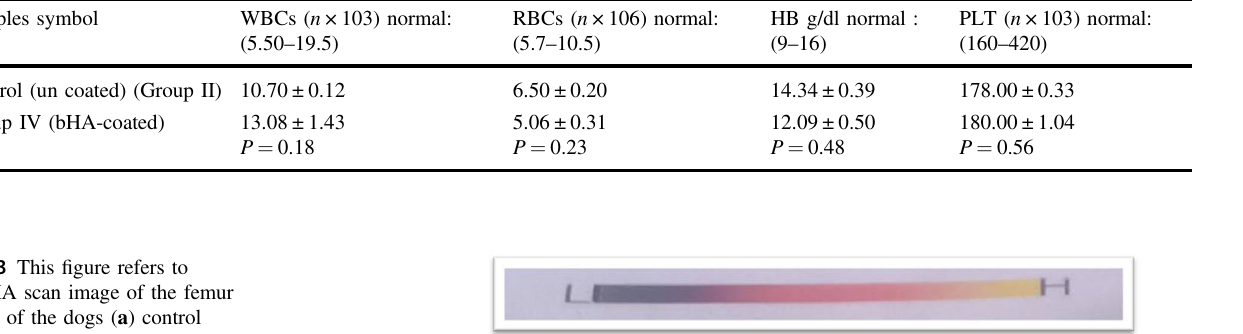
Table 5 Toxicity effects on RBCs, WBCs, hemoglobin, and PLT count at 90 days post surgery Samples symbol